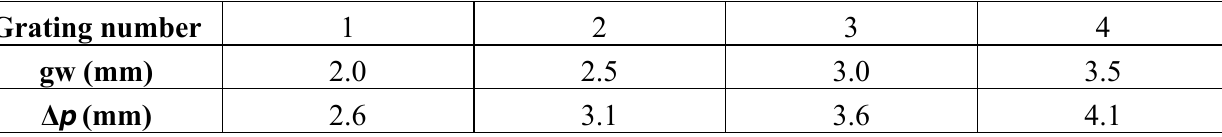
Table 1. Grating groove width ( gw ) and spatial period ( Δ p ) with respect to the sample type. Ridge width ( rw ) was fixed to 0.6 mm for all